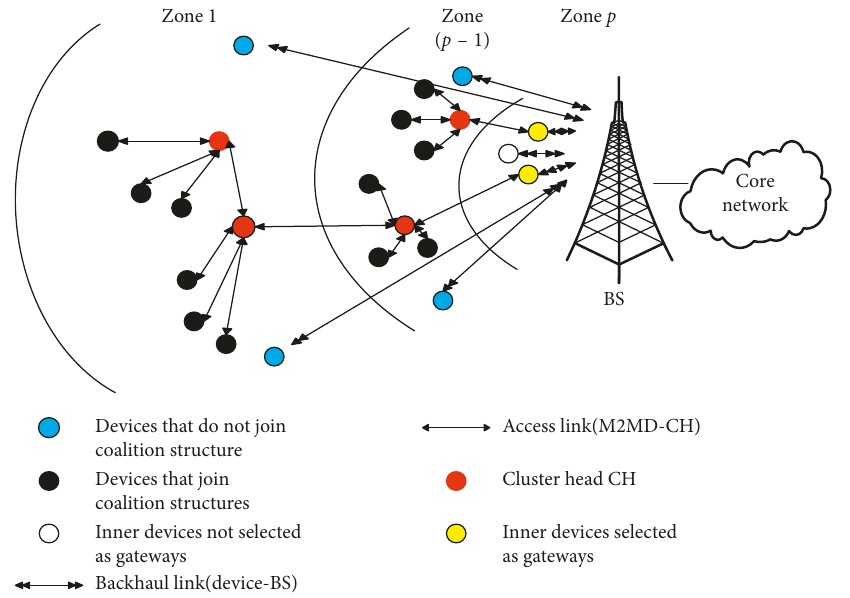
Figure 2: Structural representation of the proposed system